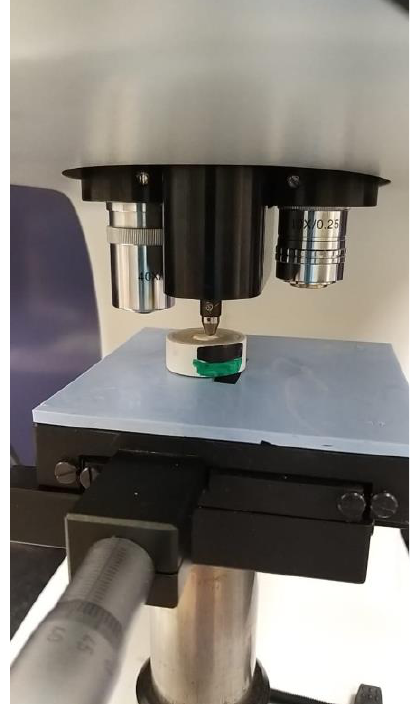
Figure 3. Microhardness testing on the teeth sample.